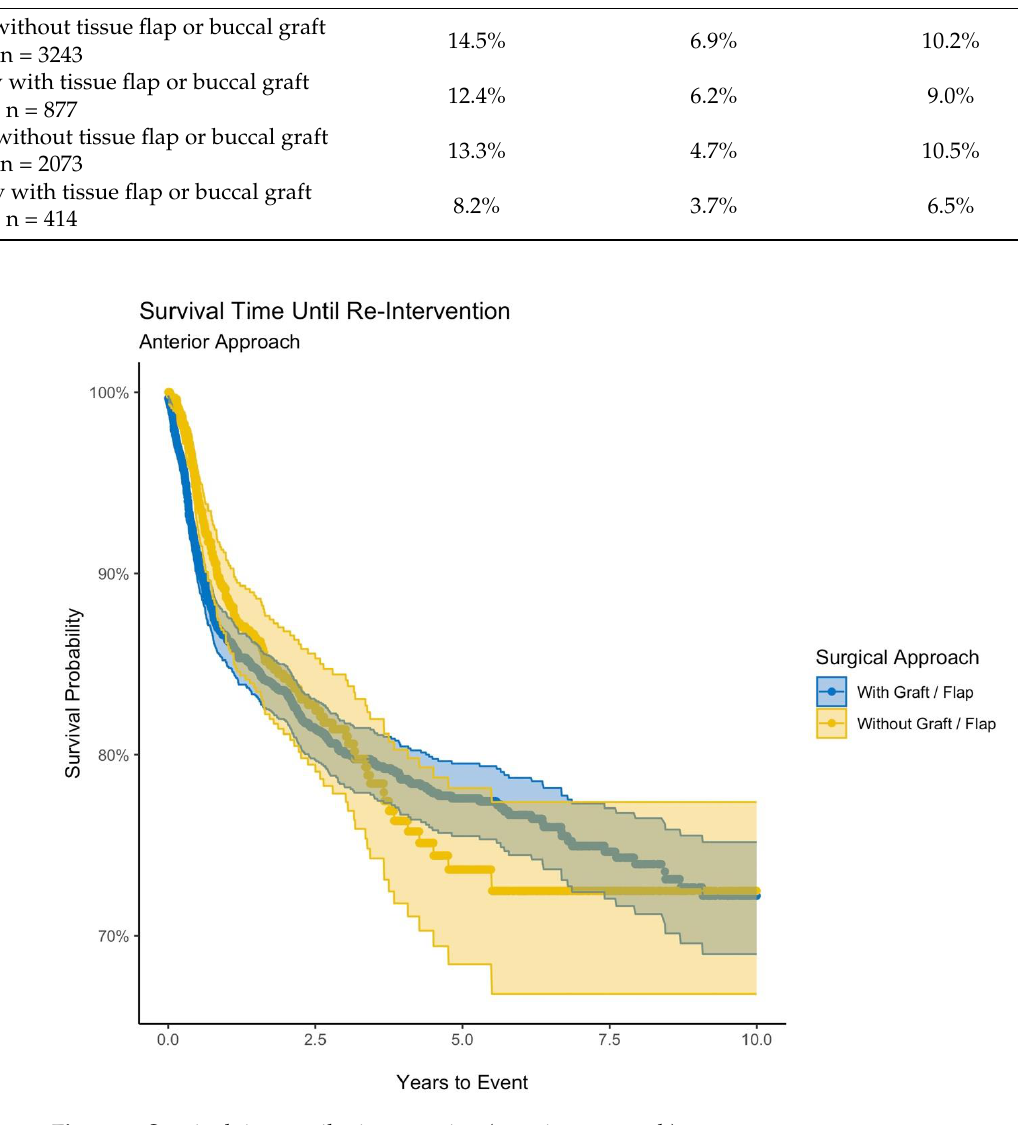
Figure 1. Survival time until reintervention (anterior approach).